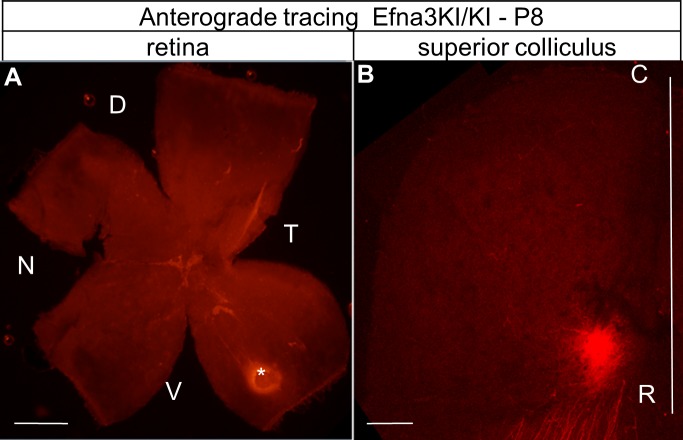
Anterograde DiI labelling showing the focal injection in the retina (white star in A) and the corresponding termination zones in the SC (B).Scale bars represent 400 µm. D, dorsal; N, nasal; T, temporal, V, ventral; R, rostral; C, caudal; SC, superior colliculus.